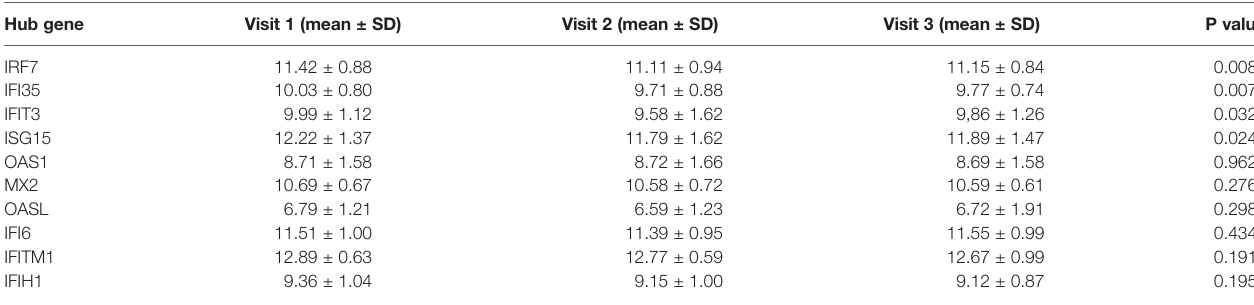
TABLE 2 | The expression levels of hub genes during follow-up. Hub gene